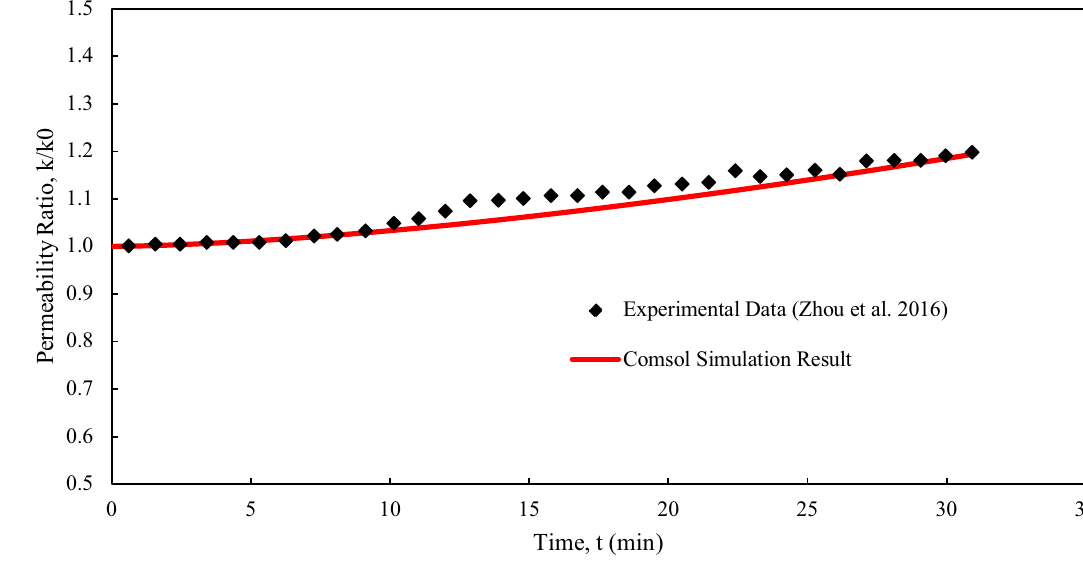
Fig. 2 Plot of comparison between fluoroboric acidizing simulation result and experimental data at 25 °C